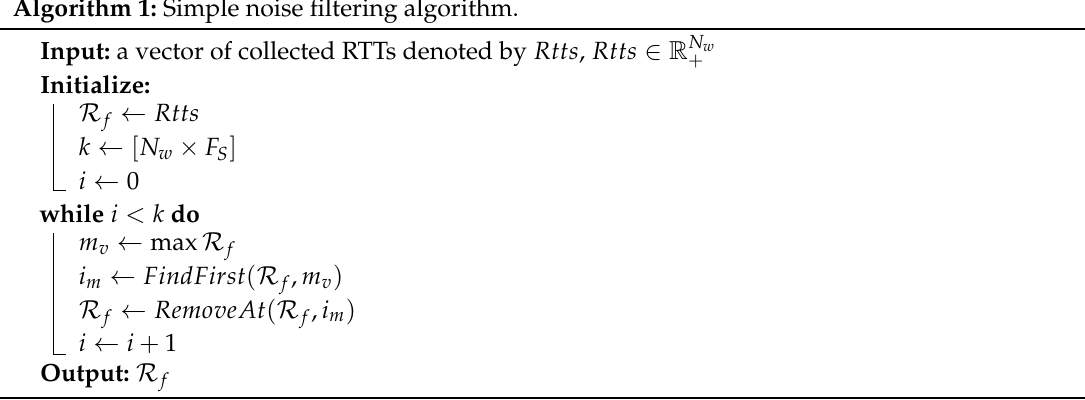
Algorithm 1: Simple noise filtering